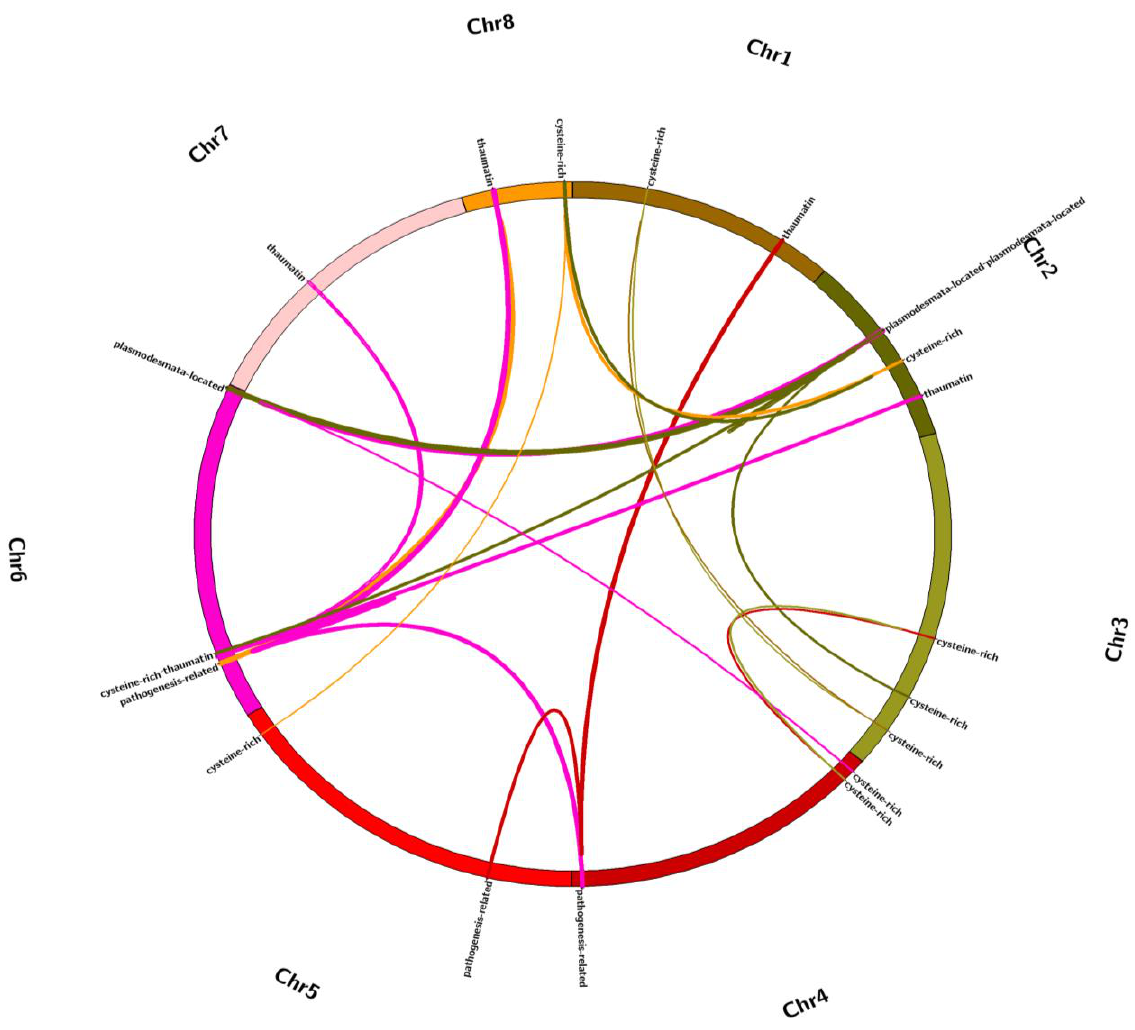
Figure 1 : The genomic location and suggested definition of predicated anti-fungal genes, where the width of the internal links indicates similarity percentage of gene